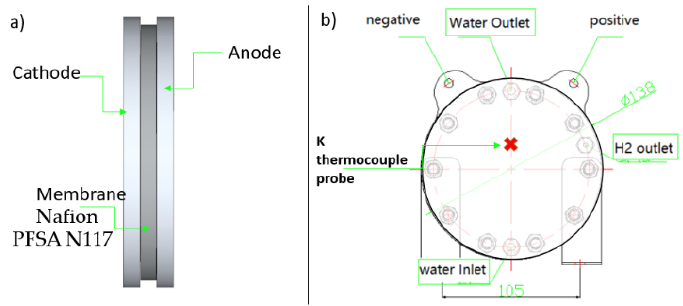
Figure 3. PEM electrolyzer cell with the measurement connections.